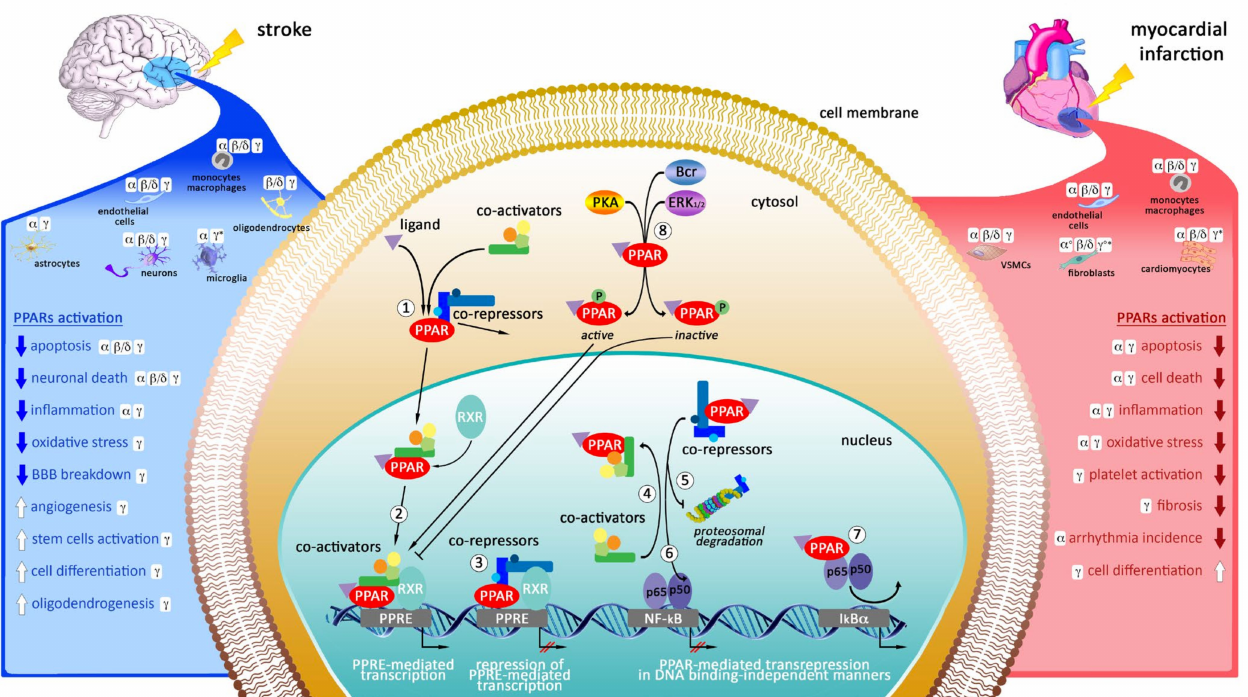
Figure 2. Schematic model representing the cellular localization, the molecular mechanisms and the effects of PPARs activa- tion after cerebral and cardiac ischemia. Under unliganded state, monomer or dimer of PPAR is bound to multicomponent repressors (1). Ligand-dependent transactivation: ligand binding to either PPAR or RXR causes displacement of bound repressors, recruitment of co-activators and activation of gene transcription (2). Ligand-independent repression: PPARs bind to response elements in the absence of ligand and recruit multicomponent repressors that mediate active repression (3). Ligand-dependent repression is provided by several mechanisms: competition for a limiting pool of co-activators (4), inhibition of repressors clearance (5), direct interaction with other transcription factors (e.g., p65/p50) (6,7). Finally, several kinases can phosphorylate PPARs modulating its activity (e.g., PPAR-mediated transcription is increased by PKA, while is reduced by MAPK and Brc kinase) (8). ◦ the expression is increased after MI; * the expression is increased after LPS